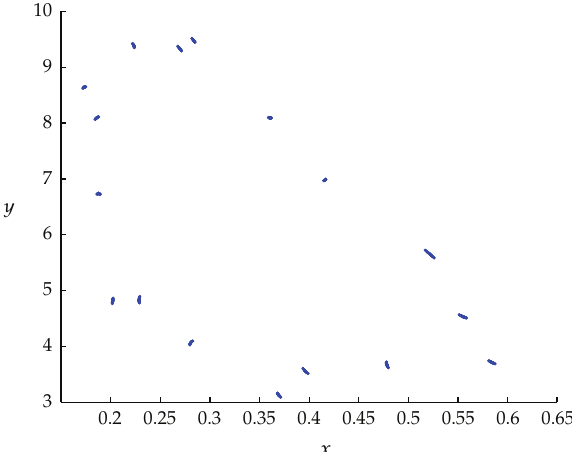
Figure 22: The existence of multiple closed curves of the system (cid:3) 2.2 (cid:4) for a (cid:8) 3 . 5, b (cid:8) 0 . 2, and d (cid:8) 3 . 215.